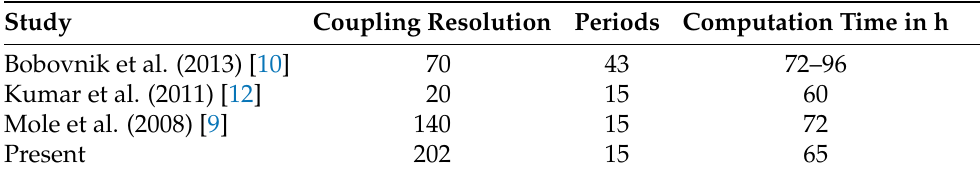
Table 7. Comparison of computation time between the present approach to literature